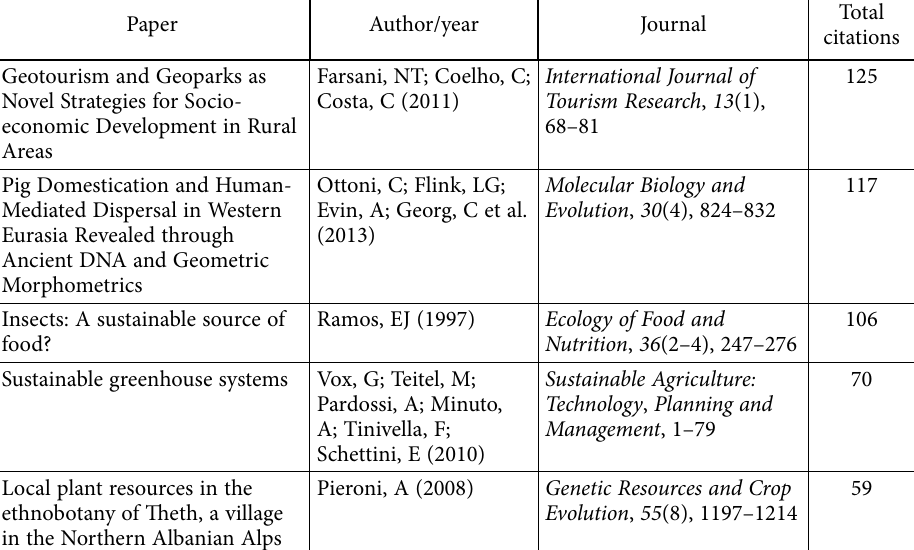
Table 3. The most frequently cited publications in WoS database Paper Geotourism and Geoparks as Novel Strategies for